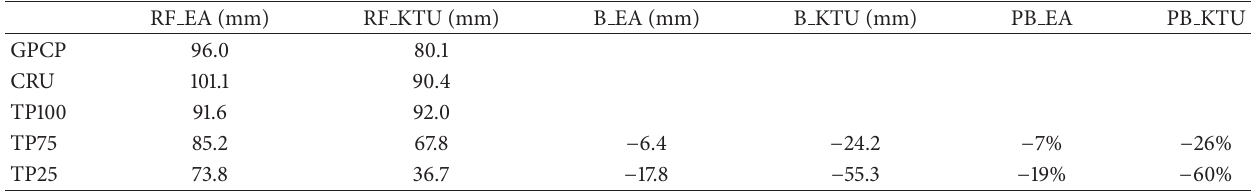
Table 2: Statistics of the model simulated mean OND rainfall (RF) in mm over east Africa (RF EA), averaged over longitudes 28 ∘ E–42 ∘ E and latitudes 12 ∘ S–5 ∘ N, and that over KTU (RF KTU), averaged over longitudes 34 ∘ E–38 ∘ E and latitudes 6 ∘ S–2 ∘ N for the control experiment (TP100), sensitivity experiments with topography reduced to 75% (TP75) and 25% (TP25), and the observed CRU and GPCP datasets. B EA and B KTU are the rainfall biases with respect to TP100, over EA and KTU, respectively. The respective percentage biases due to EA and KTU are denoted by PB EA and PB KTU.